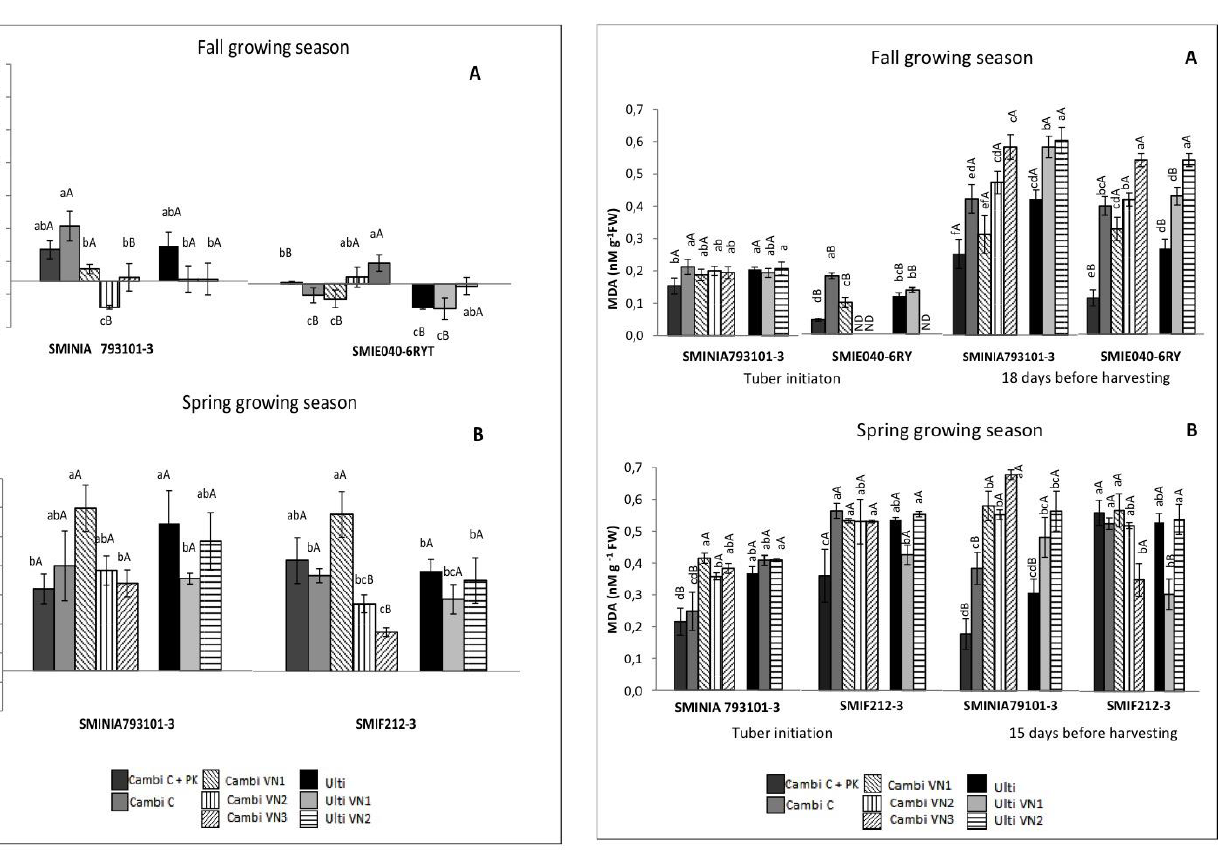
Fig. 3: Effect of increasing Cu levels on seed tuber (ST) increment per tuber at fall (A) and spring (B) growing seasons. Data represent the mean ± S.D. of six replicates. Different lowercase letters indicate significant differences between Cu levels in the same potato geno- type and growing season (p < 0.05). Different capital letters indicate significant differences between potato genotypes at the same Cu level and growing season (p < 0.05).